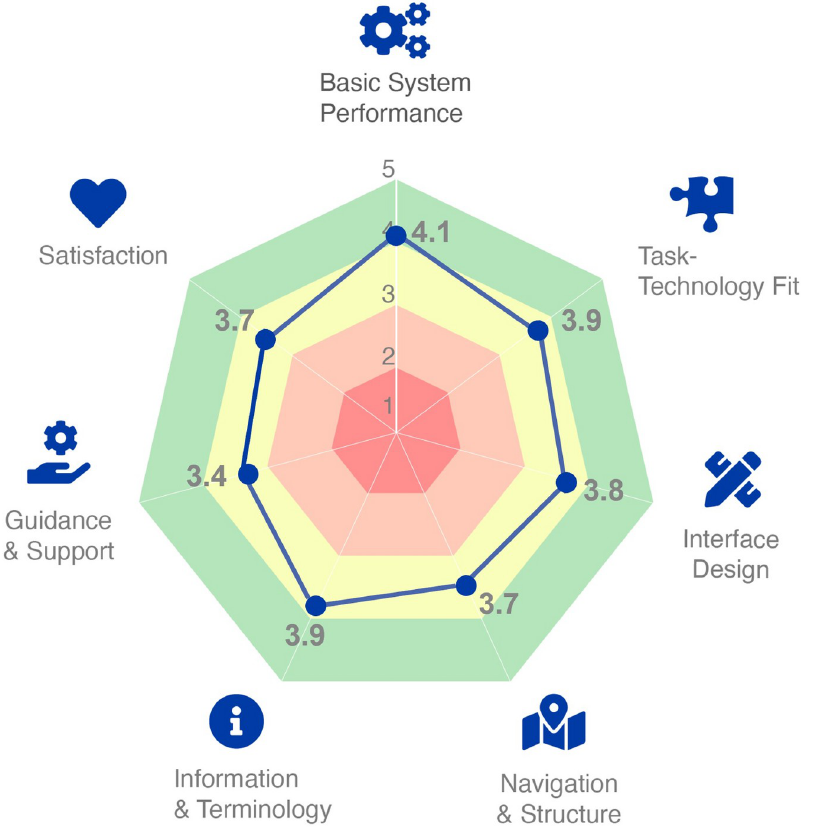
Fig 5. Visualization of the HUBBI using a radar